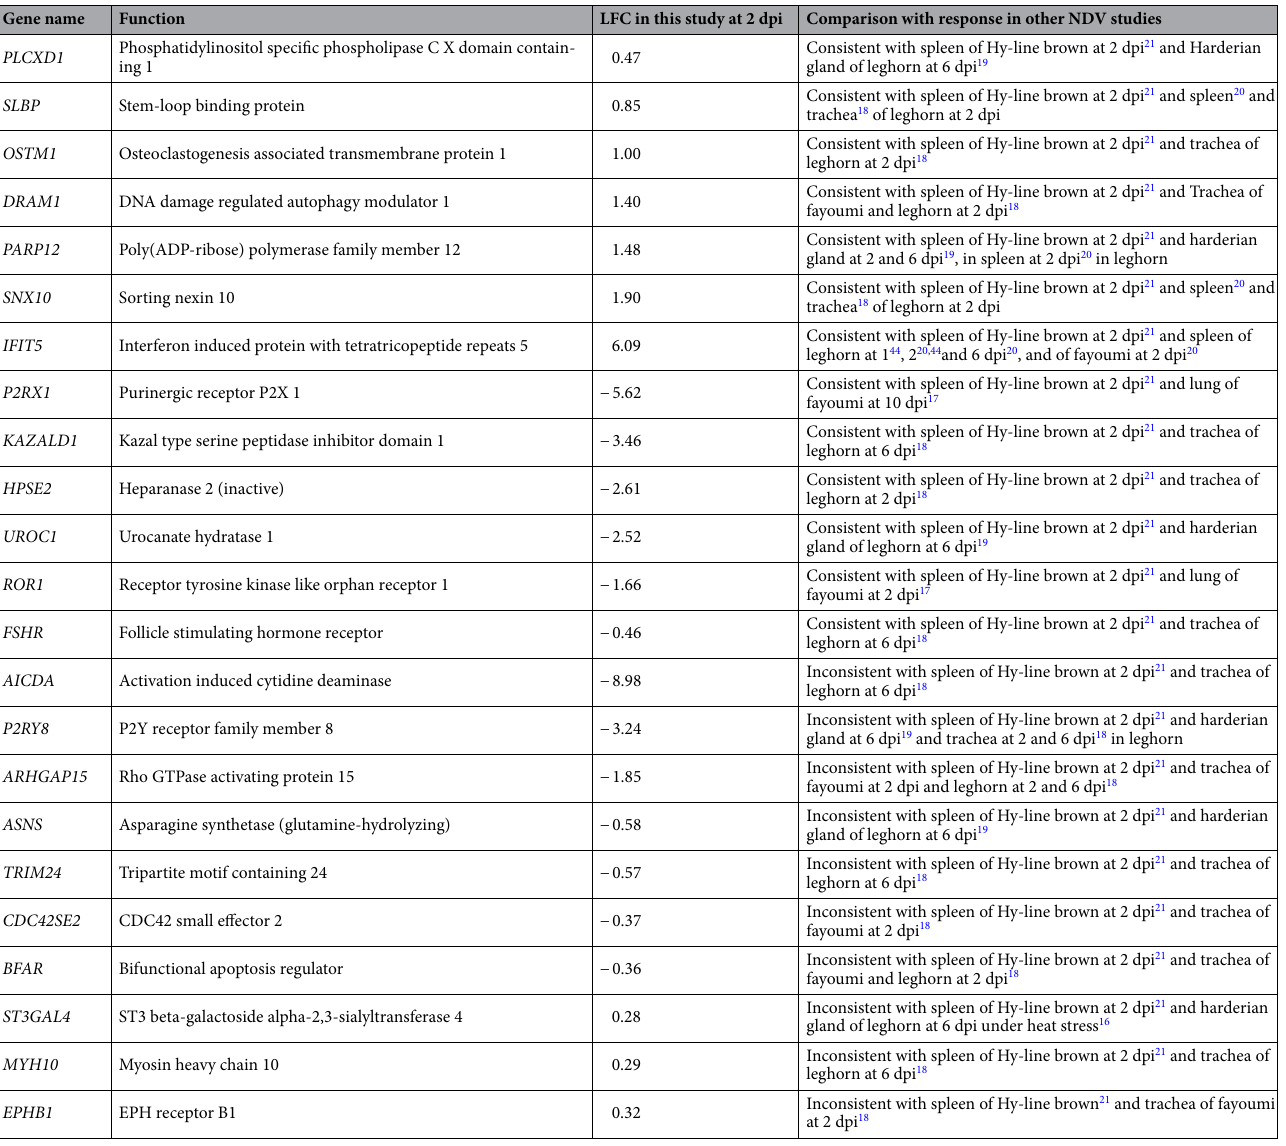
Table 3. Comparison of DEGs response to NDV in the present study and other in vivo NDV infection studies. LFC stands for log 2 fold